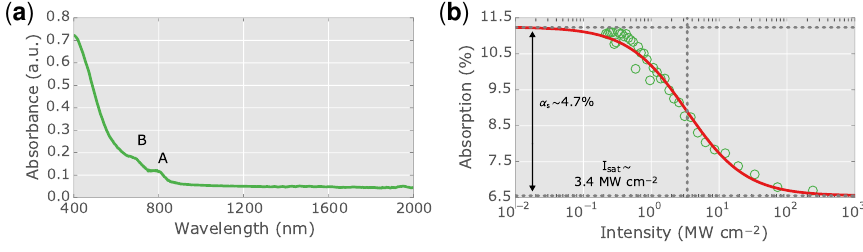
Figure 4. Characterization of MoSe -PVAcomposite, after [55]: ( a ) linear 2 absorption; ( b ) Z-scan measurement, fitted with a two-level saturable absorber (SA) model (solid red line) to determine device performance parameters. Labels A and B refer to excitonic transitions, as described in Section